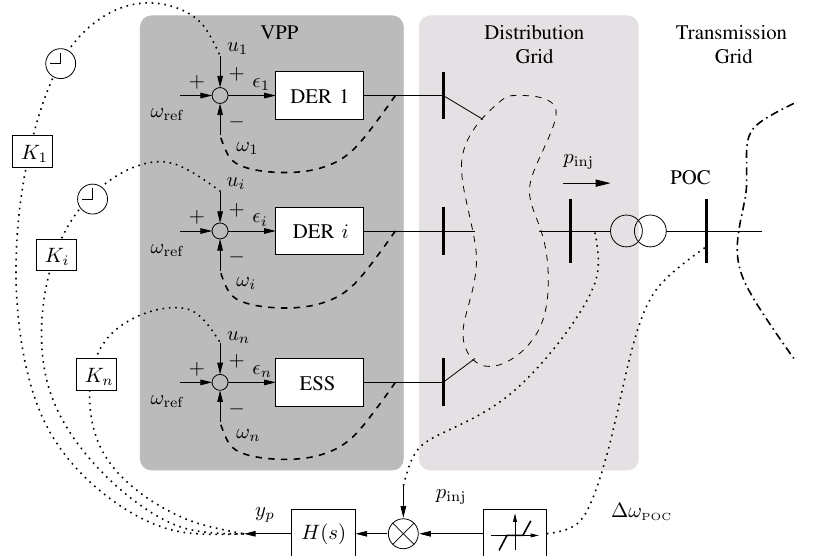
Figure 1. Control diagram of the proposed coordinated control of